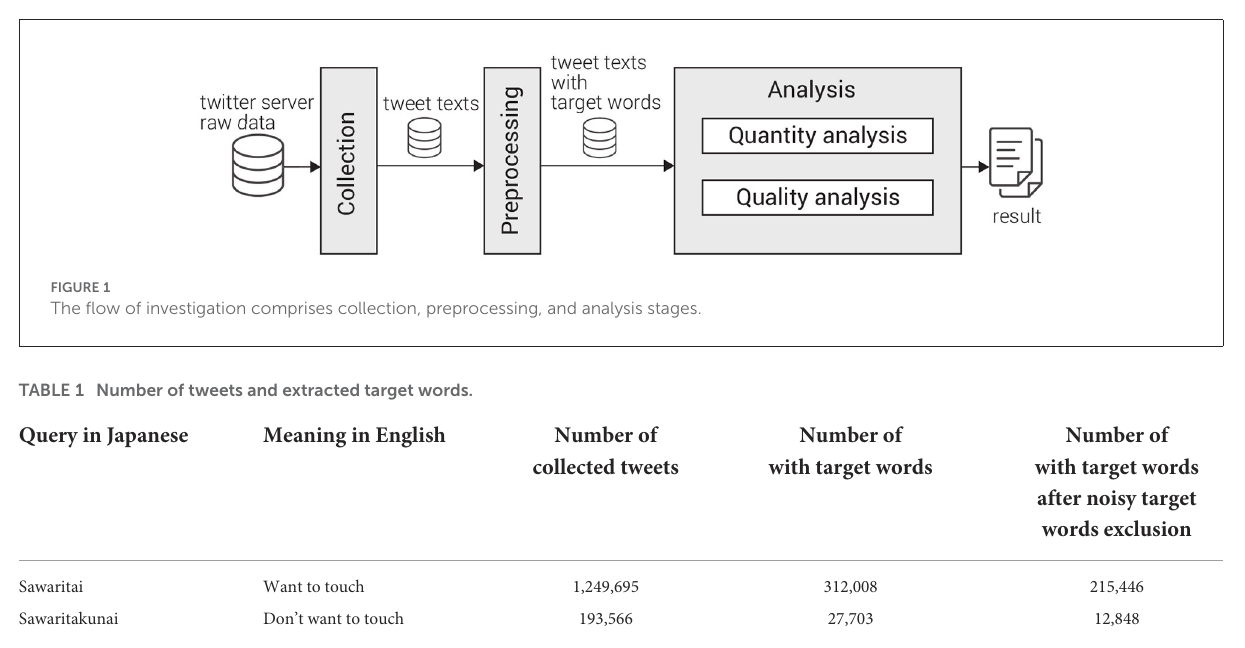
Want to touch 1,249,695 Don’t want to